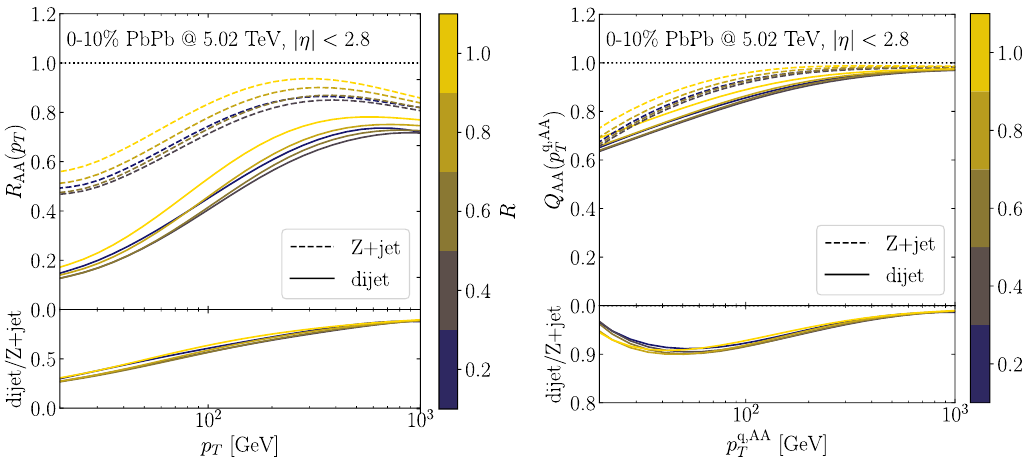
Figure 7 . The R AA and Q AA from eqs. (4.2) and (4.5) for single-inclusive jets from dijet and Z+jet events in 0–10% PbPb collision at 5.02 TeV, keeping the same parameters as in figure 5. On the instead of p q , pp like in previous x -axis of the right panel we used p q , AA T T